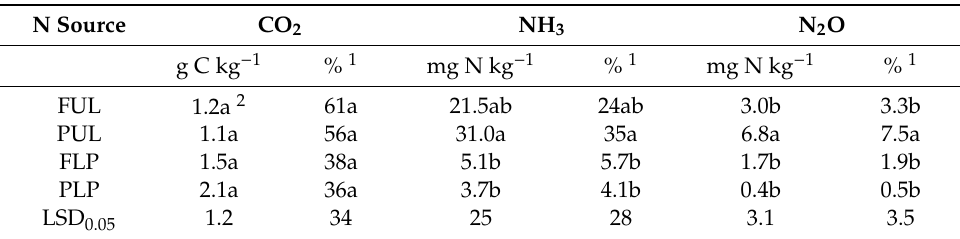
Table 3. Cumulative CO 2 , N 2 O, and NH 3 emissions corrected by subtracting the emissions of the control during 10 weeks of incubation of the soil cores that received surface application of fine-particle